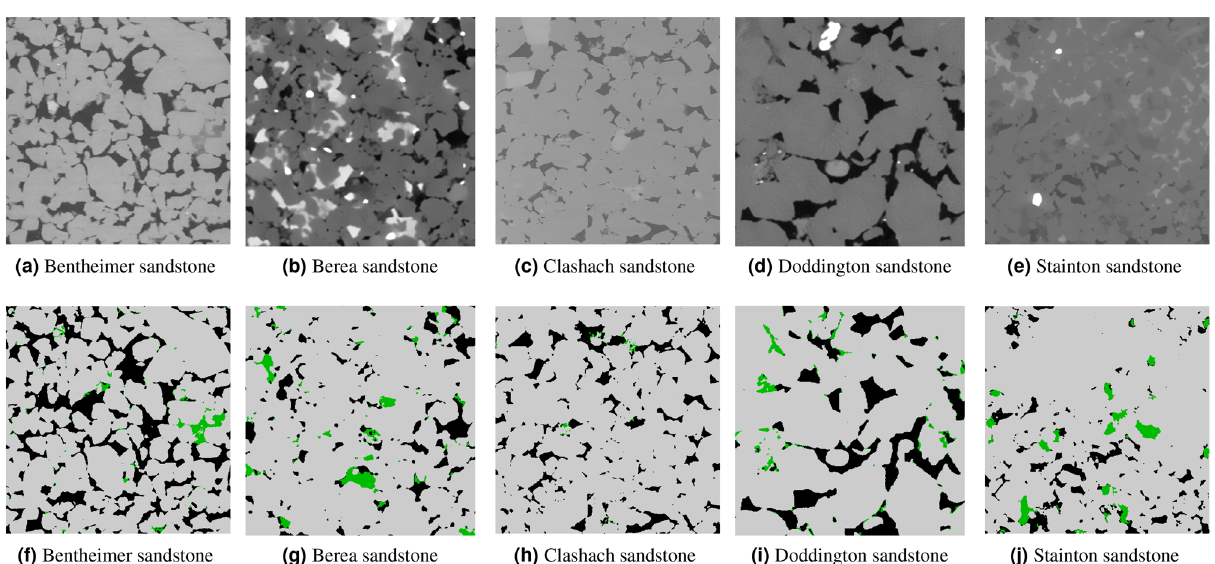
Figure 14. A full-size middle cut of 5 sandstone images and their corresponding three-phase segmentation by our